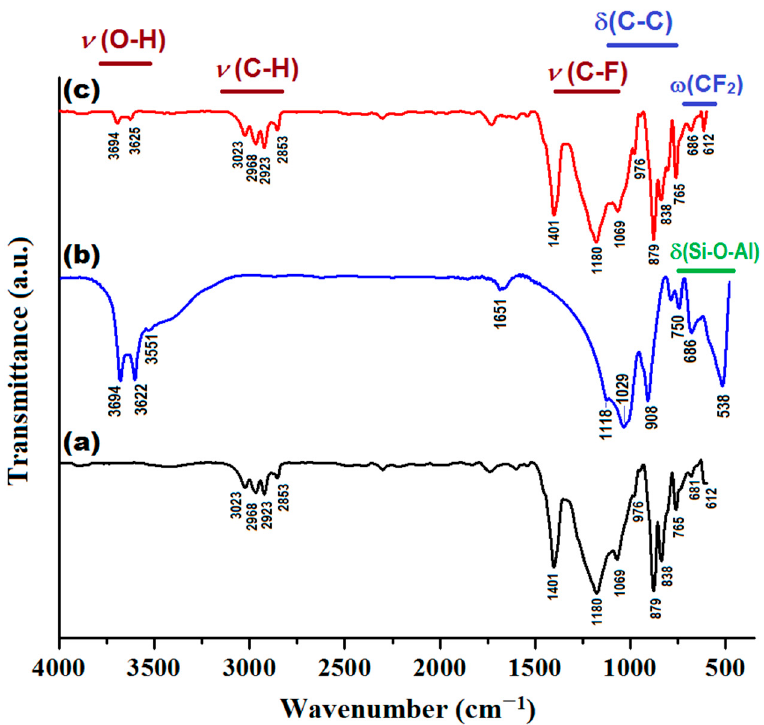
Figure 11. Infrared spectra (FTIR) of investigated materials: ( a ) PVDF-HFP membrane; ( b ) HS (Halloysite); ( c ) PVDF-HFP/HS composite membrane.